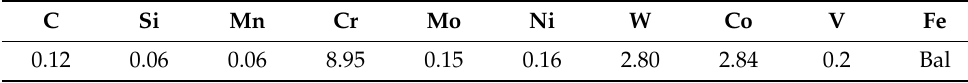
Table 1. Detailed chemical compositions of MarBN steel